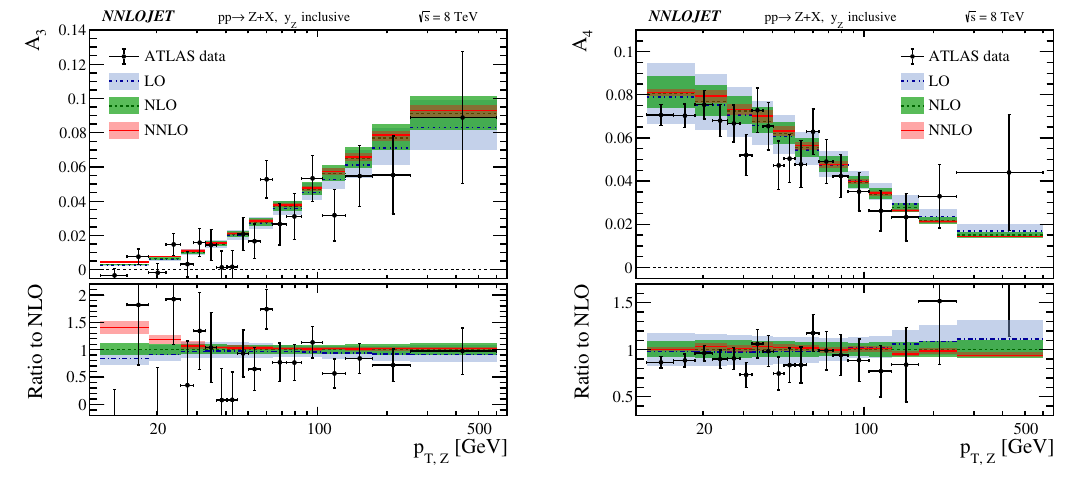
Figure 5 . The p T ; Z distribution for the angular coe(cid:14)cients A 3 (left) and A 4 (right) in pp collisions p at s = 8 TeV. The ATLAS data (black points) are compared to the LO (blue (cid:12)ll), NLO (green (cid:12)ll), and NNLO (red (cid:12)ll) theoretical predictions. In the lower panel, each distribution is shown normalised with respect to the central NLO